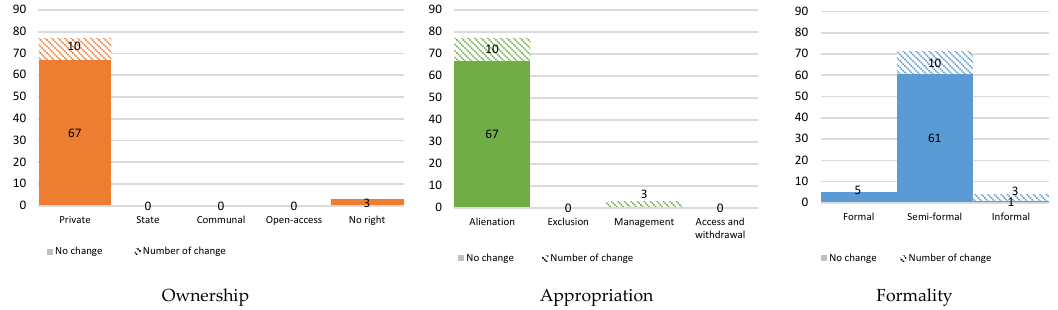
Figure 5. The number of property rights transformation on cultivated lands in KHI.